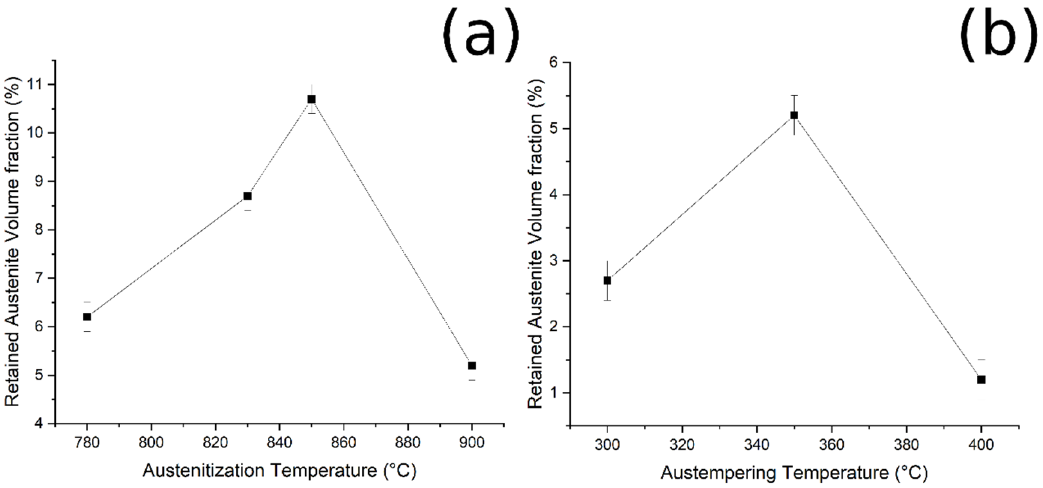
Figure 9. Relationship between ( a ) RA and austenitizing temperature, and ( b ) RA and austempering temperature (fixed austenitizing at 900 °C) .